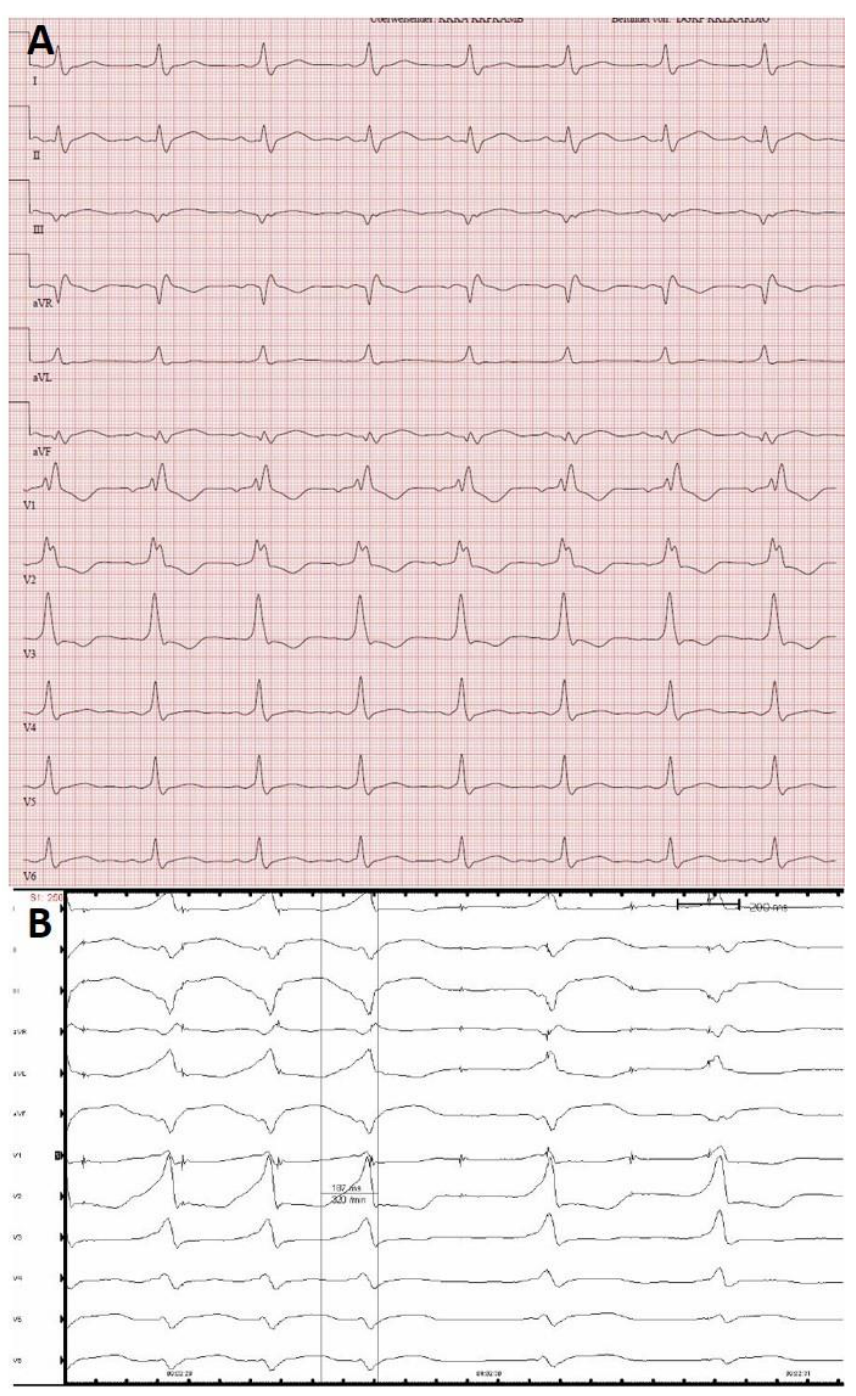
Figure 2. ECG tracings from a patient with a left posterolateral AP. ( A ) 12 lead resting ECG tracing with manifest preexcitation (50 mm/s). ( B ) 12 lead ECG tracing during atrial pacing in EPS shows a full ventricular preexcitation pattern (100 mm/s).